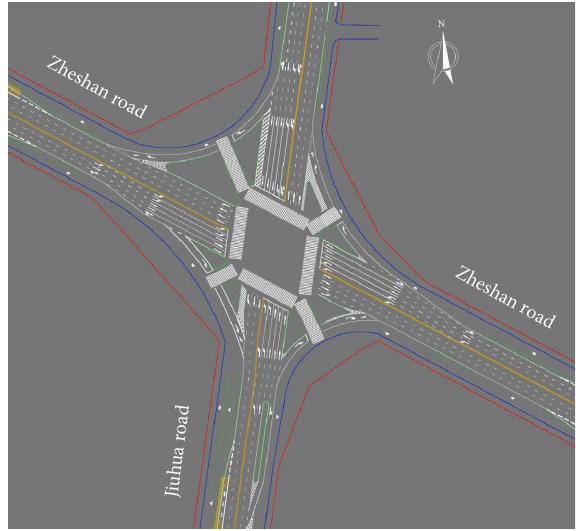
Figure 6: Canalization diagram of Jiuhua road and Zheshan road intersection.